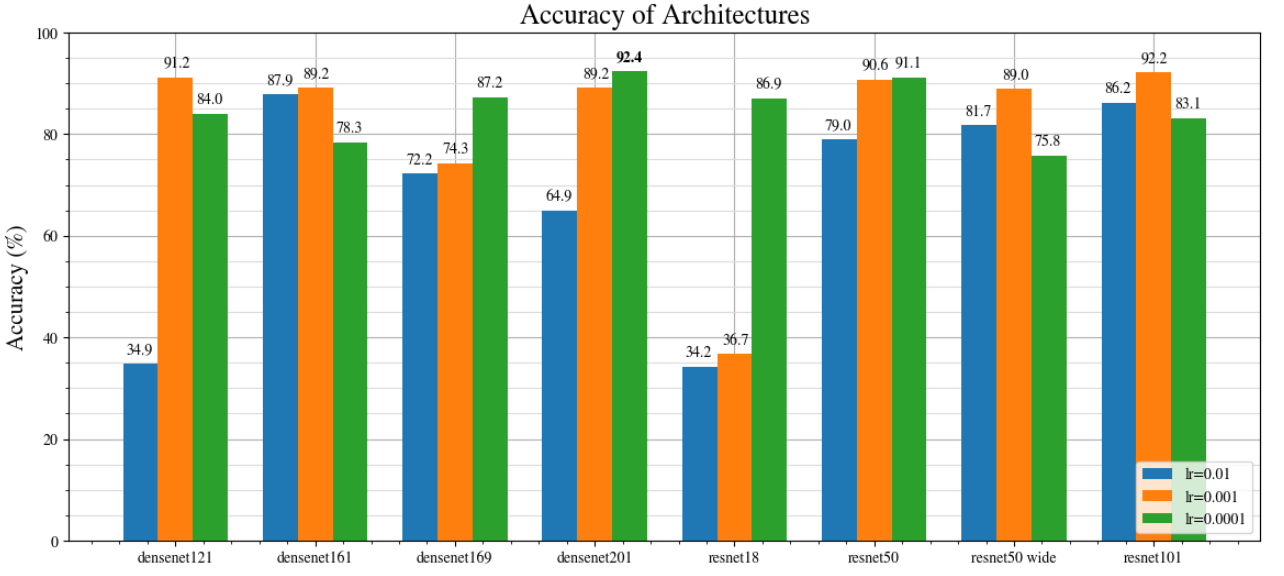
Figure 4. Accuracy of different CNN architectures at different learning rates: 0.01 (blue), 0.001 (orange) and 0.0001 (green).